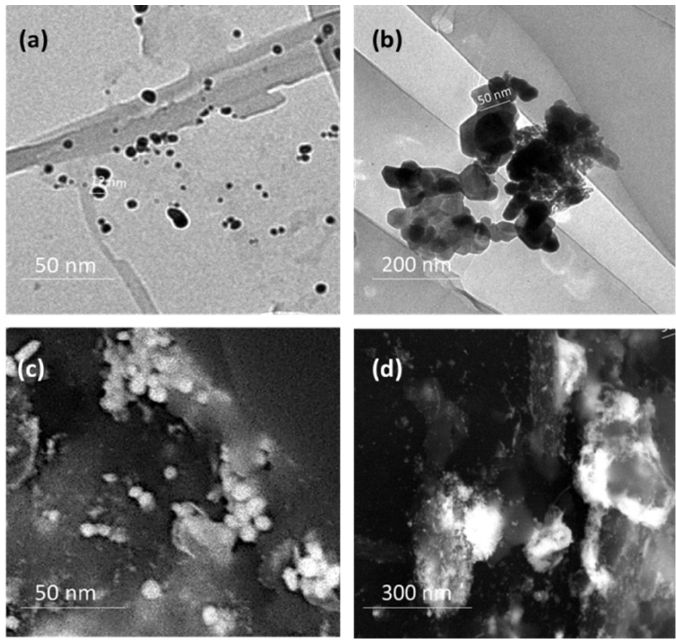
Figure 4. TEM and SEM micrographs of the prepared AuNPs ( a , c ) and AuNPs-OM 1 ( b , d ).